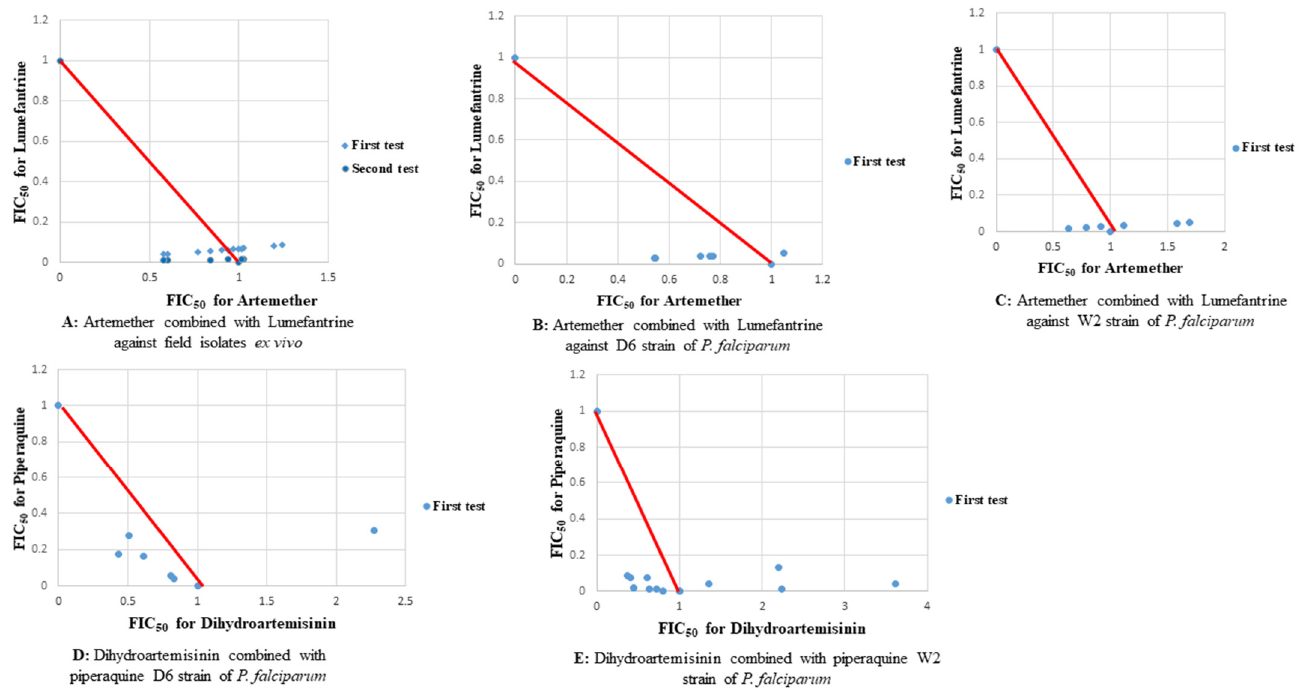
Figure 5. Scatter plots of control drugs combinations.